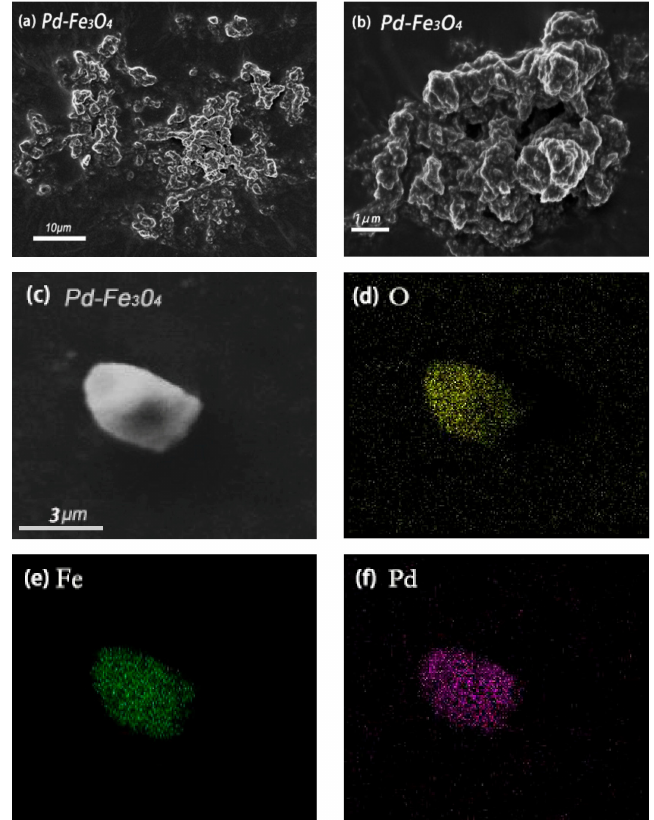
Figure 3. ( a , b ): SEM image of Pd-Fe 3 O 4 , ( c – f ): corresponding EDX mapping image of O, Fe and